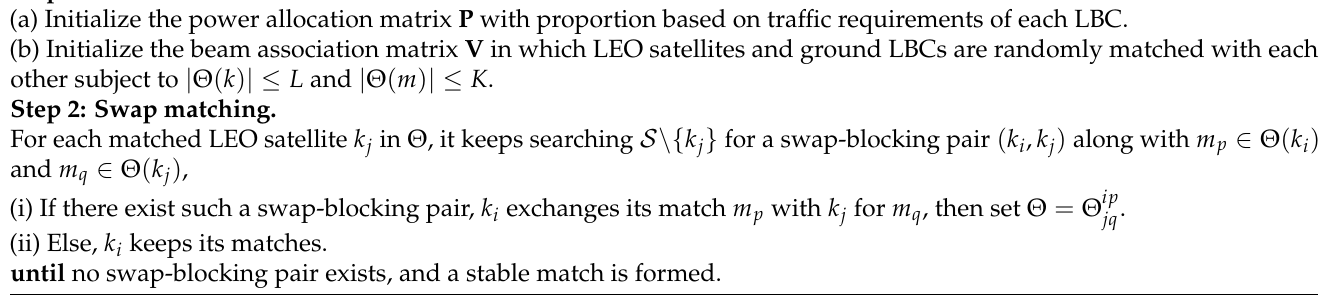
Algorithm 1 Proposed swap-matching game-based beam association algorithm. Step 1: